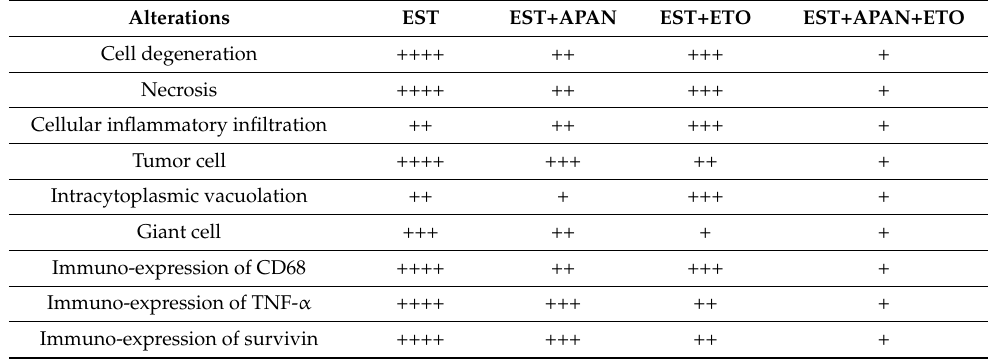
Table 3. Histopathological and immunohistochemical changes in Ehrlich tumor and hepatic tissues.